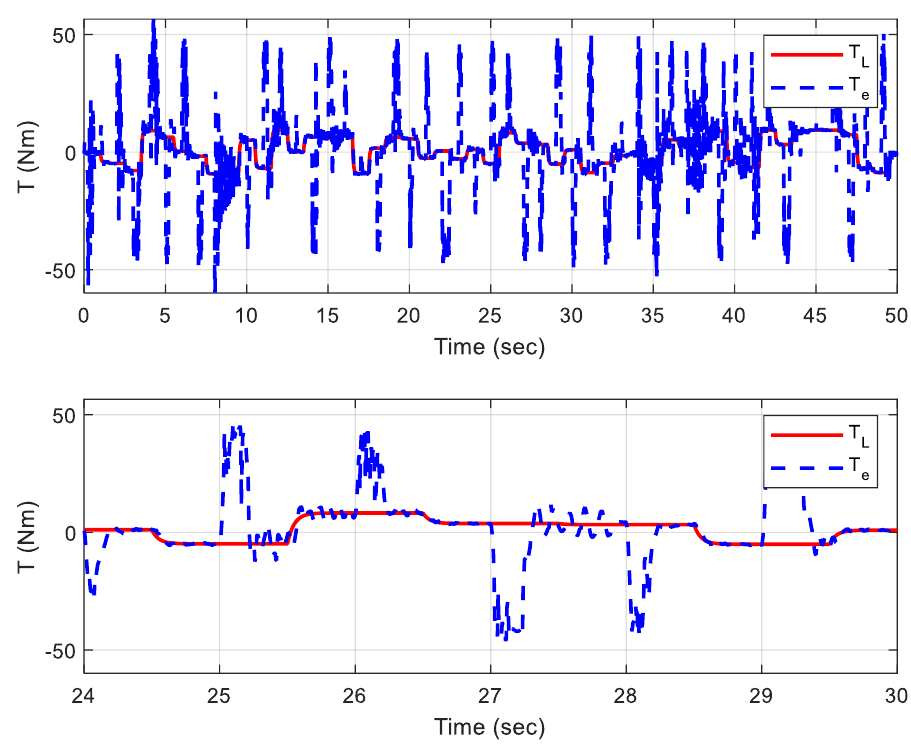
Figure 16. Dynamic performance of load and electromagnetic torques.